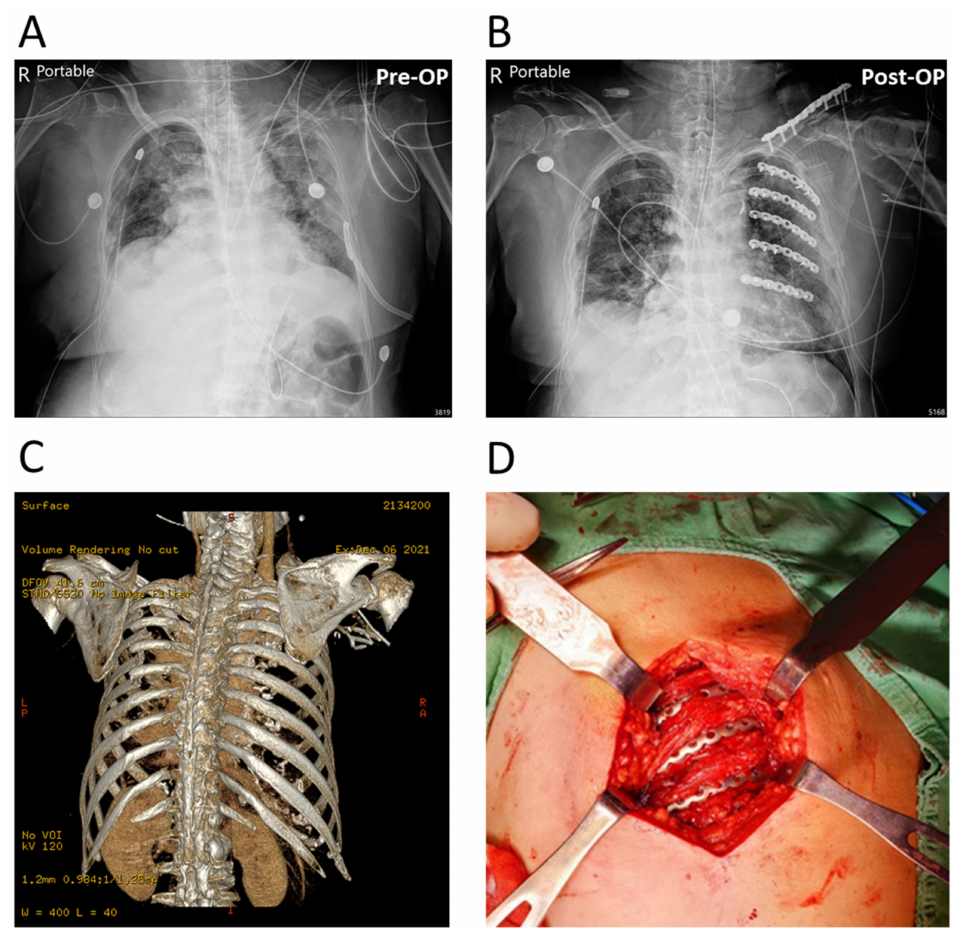
Figure 3. A representative case of multiple rib fractures repaired with APS plates. ( A , B ) AP radio- graph of pre-operation (Pre-OP) and post-operation (Post-OP). ( C ) Three-dimensional CT reconstruc- tion image of the injury. ( D ) Intraoperative photograph showing the rib-repairing technique with implanted APS